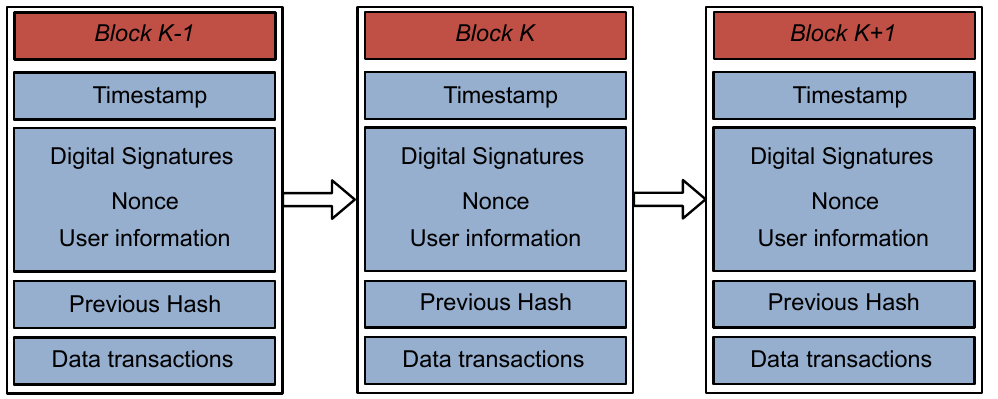
Figure 1. The structure of blockchain